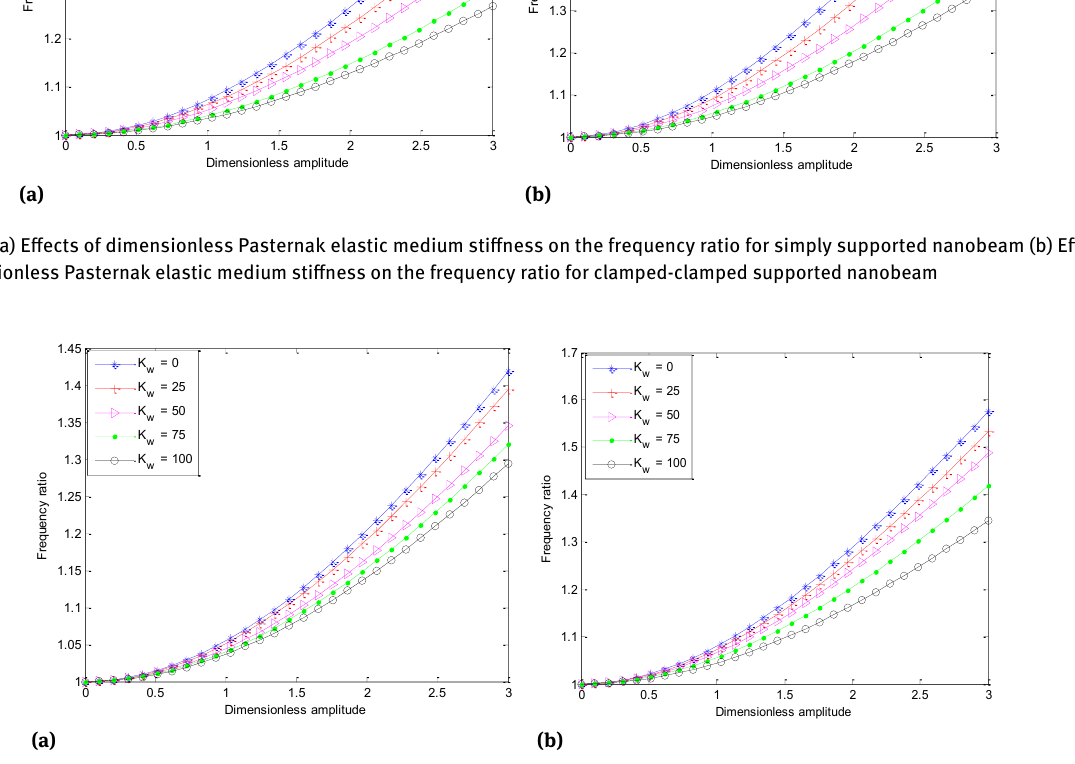
Figure 10: (a) Effects of dimensionless Winkler elastic medium stiffness on the frequency ratio for simply supported nanobeam (b) Effects of dimensionless Winkler elastic medium stiffness on the frequency ratio for clamped-clamped supported nanobeam